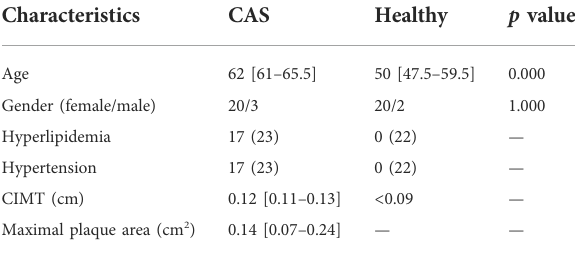
TABLE 1 Baseline characteristics of subjects. Characteristics